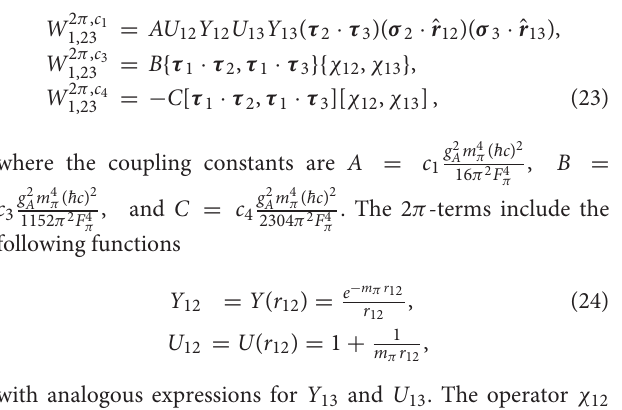
TABLE 1 | Fit values for the couplings c D and c E for different choices of 3N cut-offs as reported in references [19,